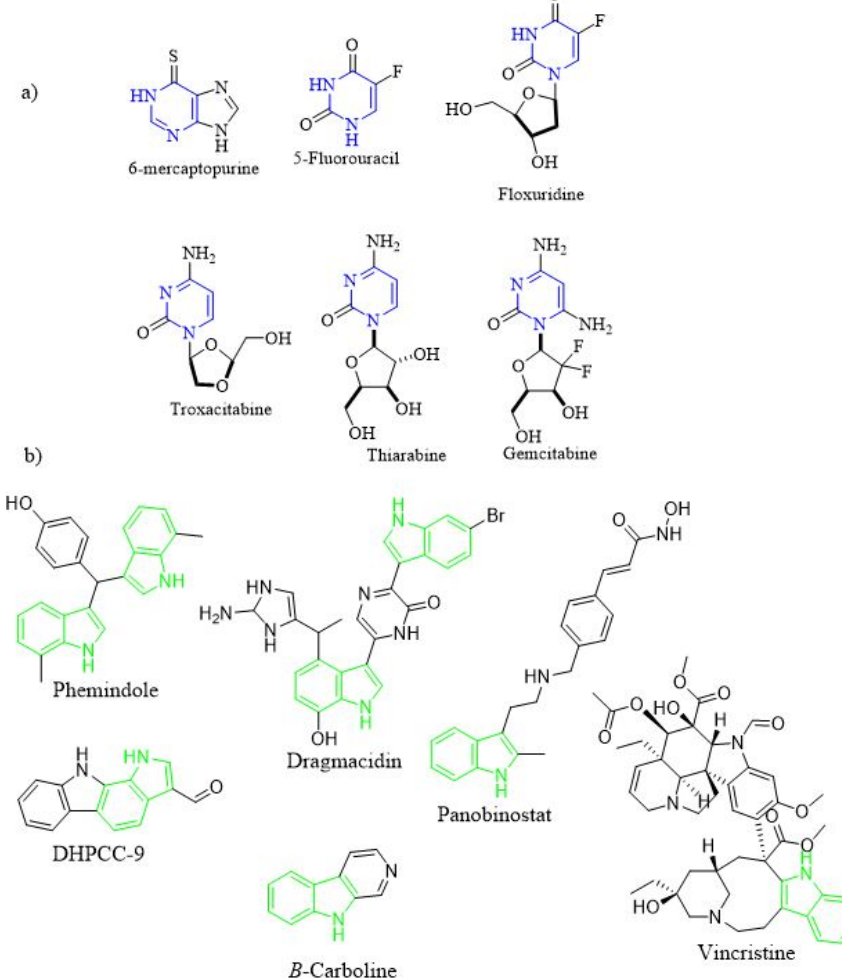
Figure 1. ( a ) Pyrimidine containing compounds as anticancer agents; ( b ) indole containing com- pounds with antitumor activity.